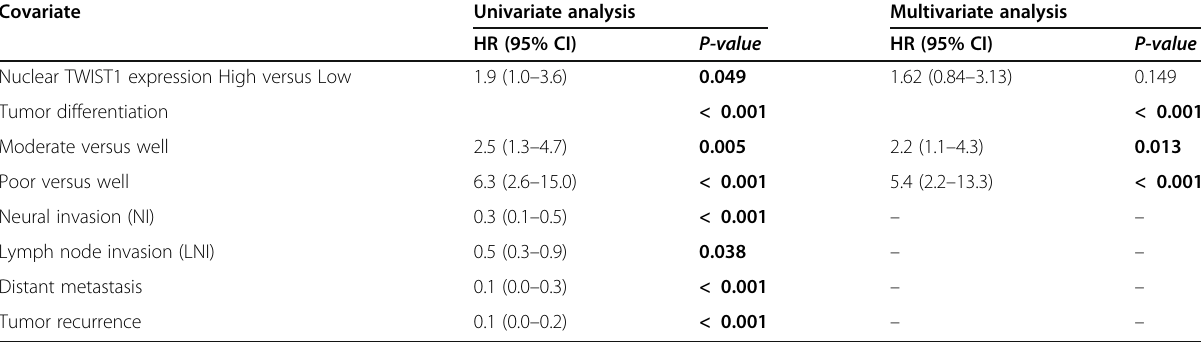
H-score indicates histological score Values in bold are statistically significant The variables with P value less than 0.05 were included in multivariable analyses hazard ratio, CI confidence interval